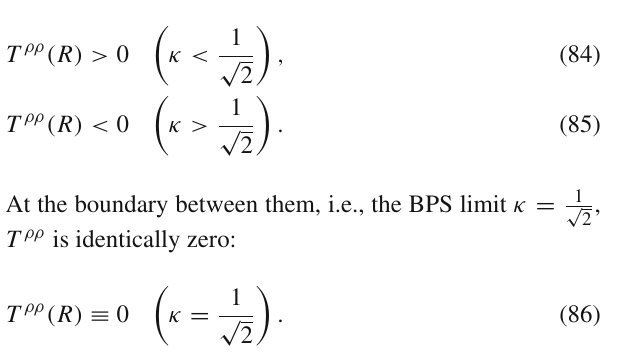
Fig. 11 The distribution of the stress forces F (ρ) and F ( z ) on the x = 0 plane for (left panel) type I ( κ = 0 . 565) and (right panel) type II ( κ = 1). We